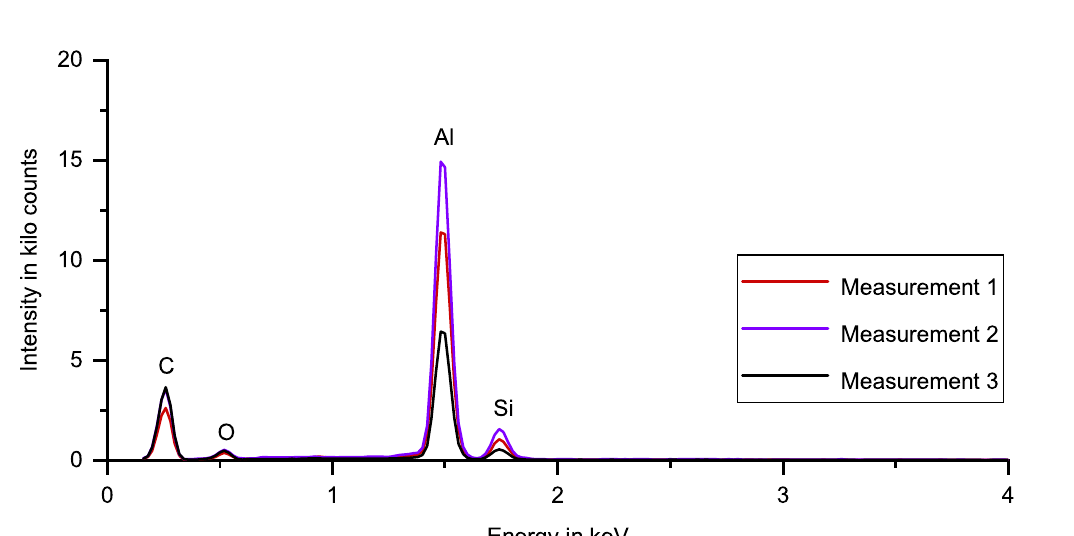
Figure 12. Three spectra for the UL-sample, superimposed in a single diagram. Aluminum, silicon, carbon and oxygen were detected. The three spectra differ in peak height, the peak positions do not